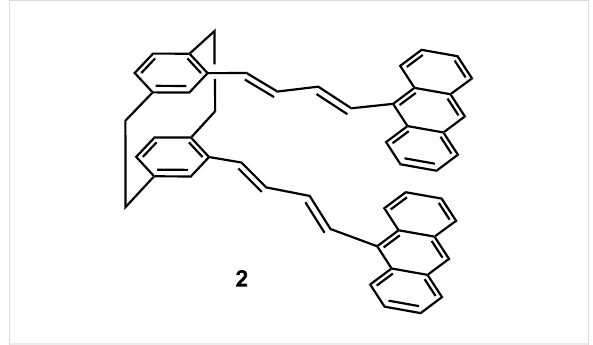
Figure 3: Molecular structure of 4,13-bis[(1 E ,3 E )-4-(9-anthracenyl)- buta-1,3-dienyl][2.2]paracyclophane ( 2